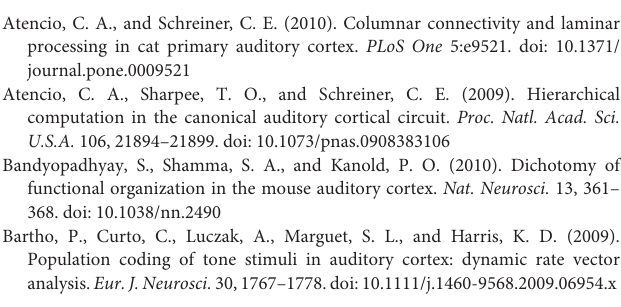
FIGURE S1 | Mouse pupil diameter indicates an intermediate arousal state on average. (a) Histogram of median pupil diameter computed from each experiment. (b) Histogram of pupil diameters over the course of each experiment where each subplot represents an individual imaging session. Most experiments exhibit a peak near the middle of the pupil diameter range, indicating an intermediate arousal state. FIGURE S2 | No epileptiform activity evident in any mouse strains. Scatter plots of prominence and width of peaks taken from the mean fluorescence trace over time of the entire 2-photon field of view. Each plot represents an individual experiment. Epileptiform activity would be evident as a secondary cluster of points at high prominence and low width. FIGURE S3 | Power laws are independent of stimulus sound level. (a) Re-scaled power law distributions for ensemble sizes from L4 (left) and L2/3 (right) data. Variable s indicates ensemble size, P(s) indicates probability of ensemble size s , a is the best fit slope from the original ensemble distributions, L is the stimulus sound level, and b is the scaling factor. (b) Conventions as in a , except for ensemble duration where variable d is ensemble duration. TABLE S1 | Statistical comparisons of the log-likelihood ratio values of avalanche size distributions and shuffled avalanche size distributions. TABLE S2 | Statistical comparisons of the log-likelihood ratio values from avalanche duration distributions and shuffled avalanche duration